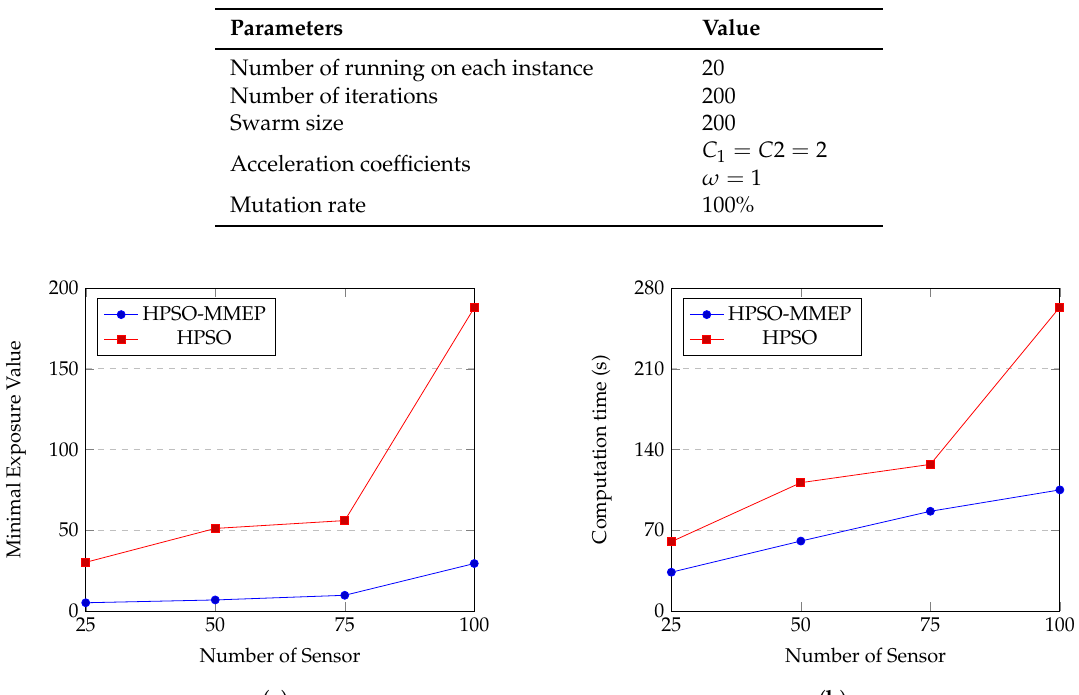
Figure 13. Comparison between HPSO-MMEP algorithm and HPSO algorithm regarding ( a ) the minimal exposure value; ( b ) the computation time when the number of sensor varies from 25 to